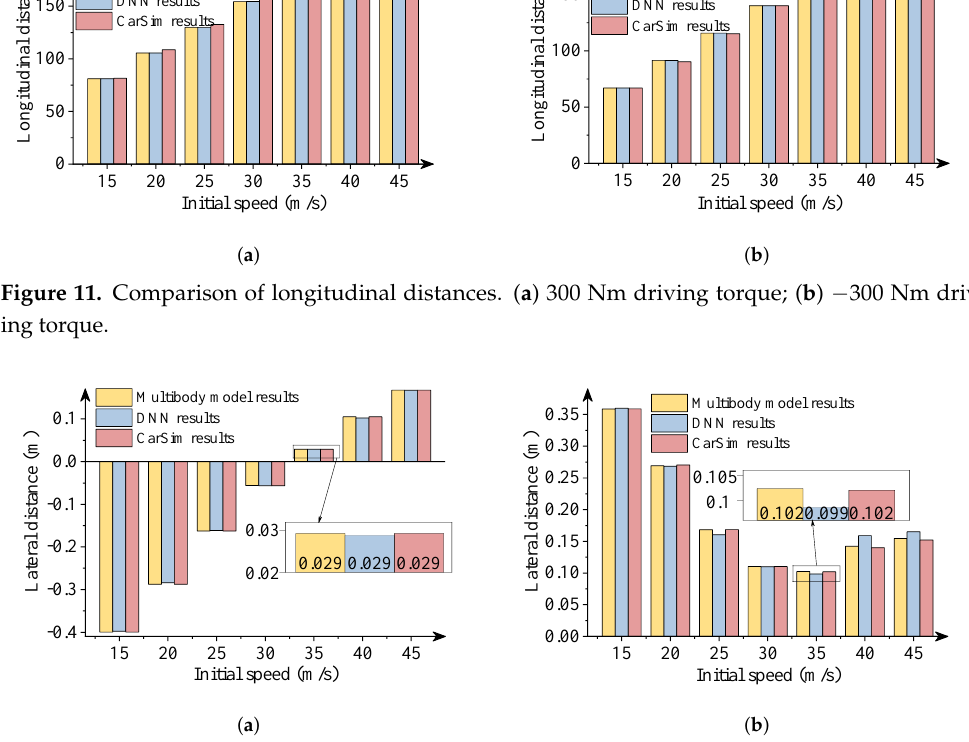
Figure 12. Comparison of lateral distances. ( a ) 300 Nm driving torque; ( b ) − 300 Nm driving torque.